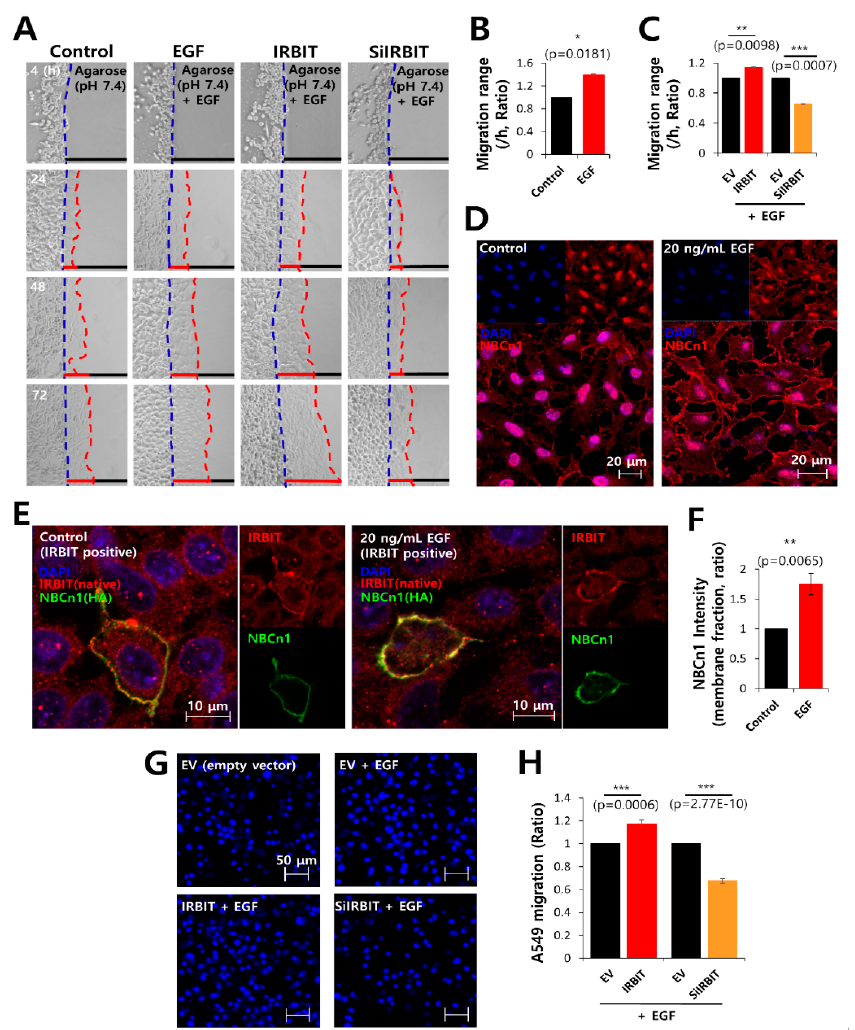
Figure 6. IRBIT expression preserved the expression of NBCn1 in the plasma membrane. ( A ) Time-dependent representative images of migration of A549 cells toward the agarose spots containing PBS (pH 7.4) and 20 ng/mL EGF, along with IRBIT and SiRNA-IRBIT (SiIRBIT) for indicated times. ( B , C ) Analysis of the migration range per hour. The bars indicate the mean ± SEM of data ( n = 4). ( D ) Immunostaining images of NBCn1 (red) and nucleus (DAPI, blue), in the presence or absence of 20 ng/mL EGF in A549 cells. The scale bars of the magnified images represent 20 μ m. ( E ) Immunostaining images of IRBIT (red), nucleus (DAPI, blue), and NBCn1 (green) in the presence or absence of 20 ng/mL EGF in A549 cells. The scale bars of the magnified images represent 10 μ m. ( F ) The bars indicate the mean ± SEM of NBCn1 intensity per membrane fraction ( n = 4). ( G ) A549 migration was measured by a transwell membrane migration assay. The cells were incubated with reagents indicated hereafter (bottom chamber: with or without 20 ng/mL EGF; upper chamber: with empty vector [EV, Control], IRBIT, and SiIRBIT). Immunofluorescence staining images with DAPI (blue). The scale bars represent 50 μ m. ( H ) Analysis of the total intensity of DAPI for A549 migration. The bars present the mean ± SEM of data ( n = 4). 3.7. Combined Inhibition of CaMKII and NBC Markedly Inhibited Cell Migration IRBIT functions downstream of CaMKII, and is phosphorylated by the CaMKII protein [1,6]. To evaluate therapeutic candidates that target cell migration by inhibiting the phosphorylation of IRBIT, the cells were treated with the NBC inhibitor S0859, CaMKII inhibitor KN93 [34], and a